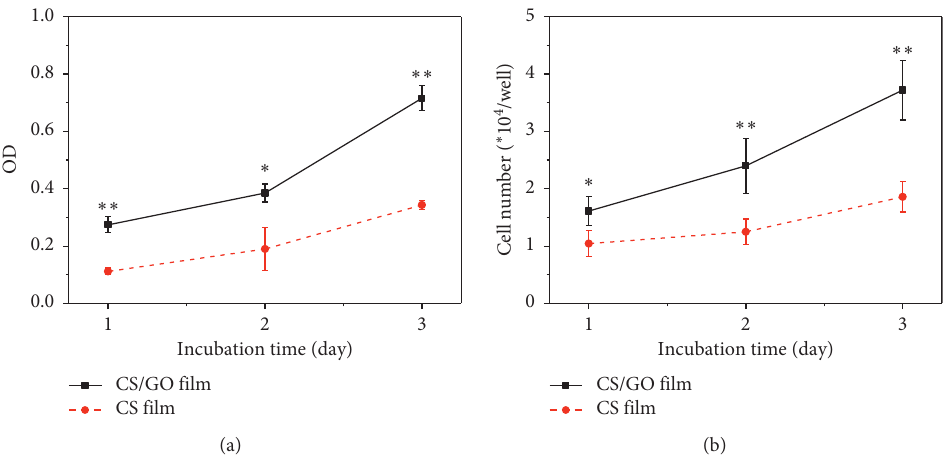
Figure 8: Cell viability (a) and cell number (b) as a function of incubation time on CS/GO films and CS films. ∗ p < 0 . 05 and ∗∗ p < 0 .